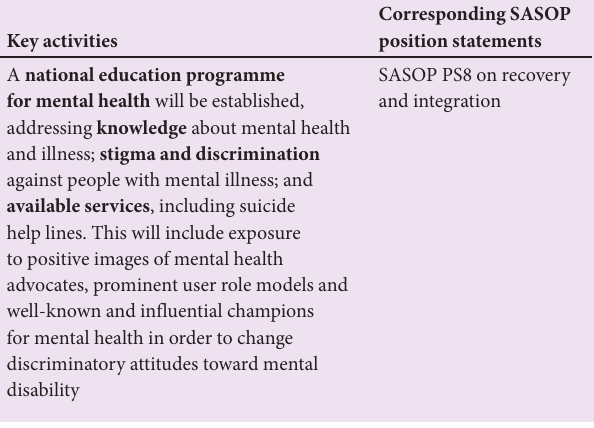
Table 8. Objective 8: Advocacy, mental health promotion and prevention of mental